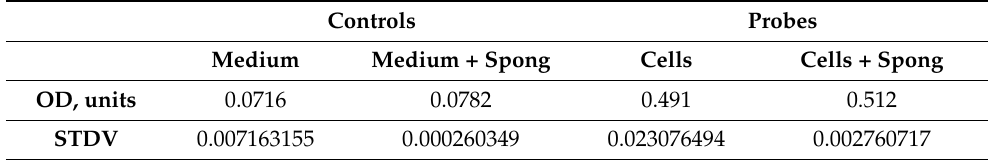
Figure 7. Demineralized spongiosa using the Lyoplast ® technology with populated chondroblasts: ( a ) populated viable chondroblasts on the surface of the biocarrier (arrows indicate attached cells). Live/Dead ® fluorophore staining. Fluorescence microscopy, ×100; ( b ) cells inhabiting the surface of trabeculae are marked by arrows. SEM, ×100.